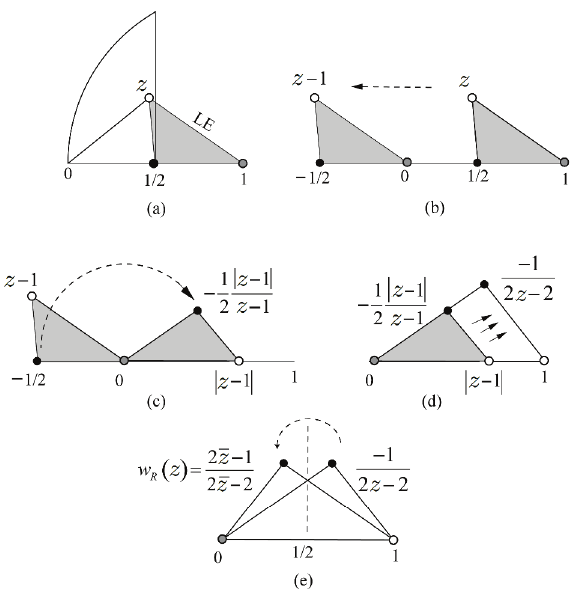
R ( z ) , where the longest-edge of the right triangle is as depicted in (a), and z − 1 . 2 z − 2